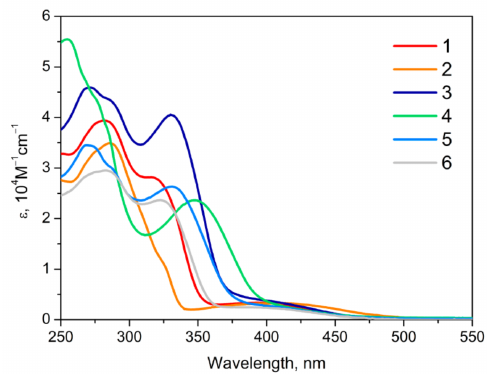
Figure 3. Absorption spectra of 1 − 6 in dichloromethane solution at